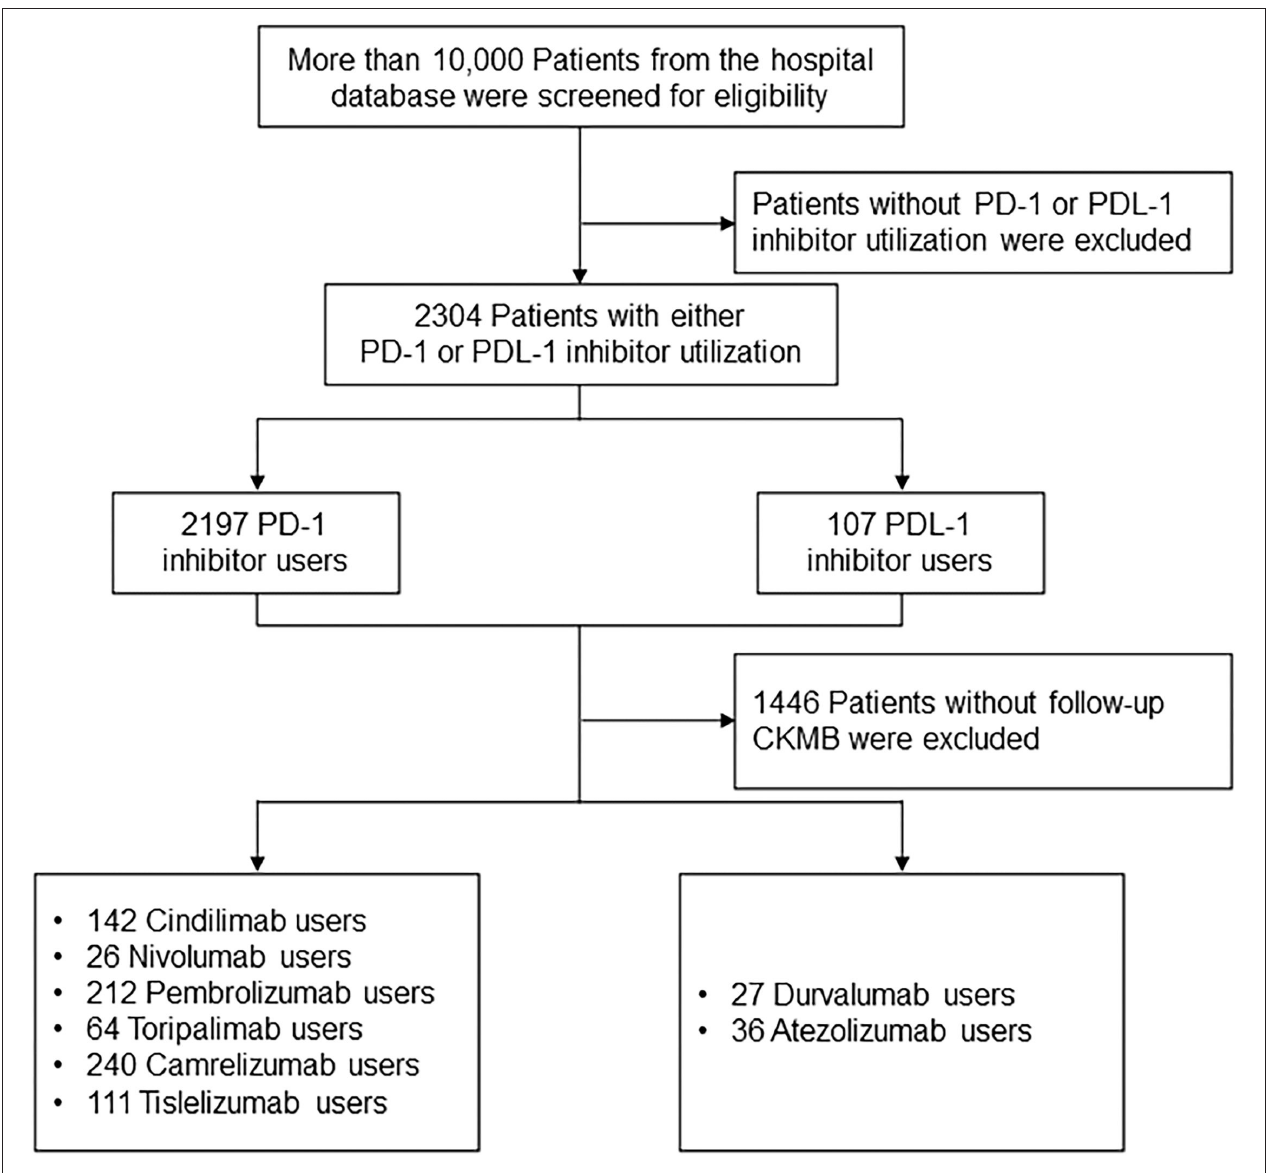
FIGURE 1 | Patients’ selection, screening, and